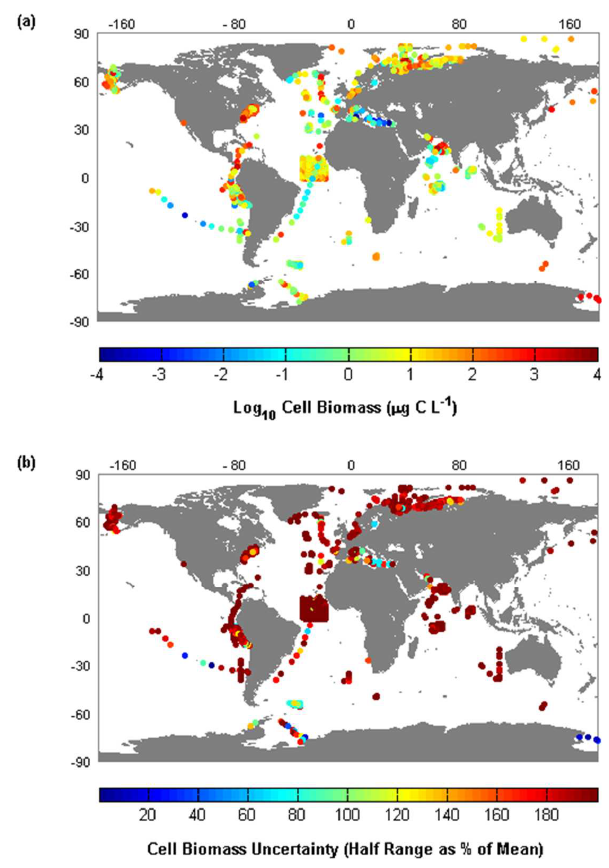
Figure 5. Mean surface log-normalized diatom biomass (log 10 µ gCl − 1 ) (a) , and uncertainty in cell biomass in % of the mean due to the uncertainty of cell size ( = (max biomass − min biomass) / mean biomass · 100) (b)